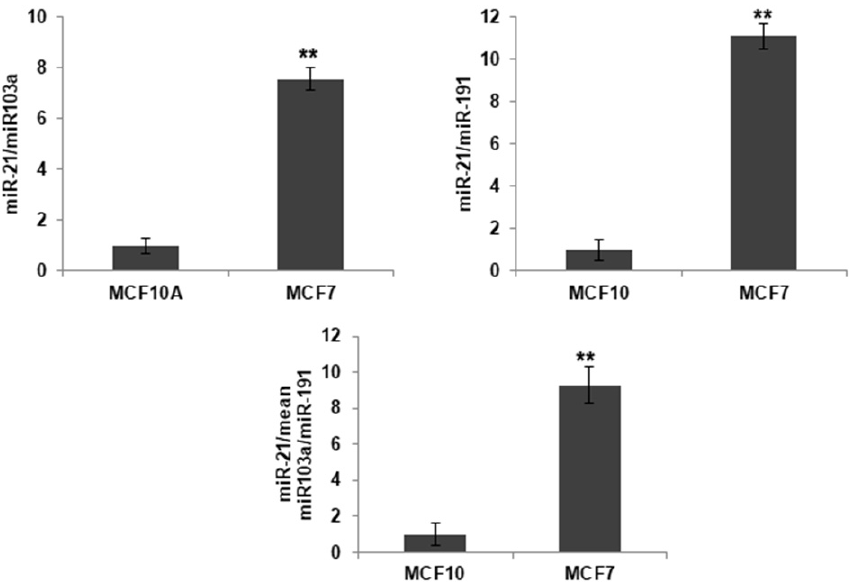
Figure 1. Basal expression of miR-21 in the MCF7 and the MCF10A cell lines. Relative expression levels of miR-21 were calculated upon miR-191 and miR-103 (house keeping genes) normalization, respectively, and mean expression value normalization of both miRNAs. Values represent means ± SD ( n = 3). ** p < 0.01.